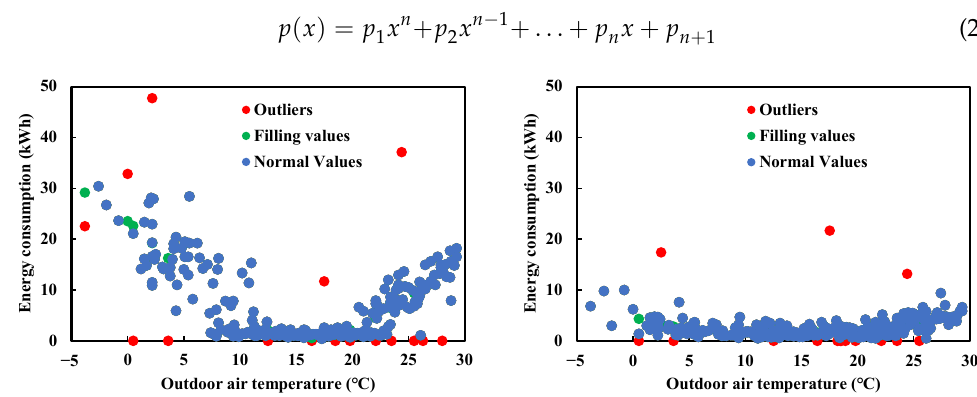
Figure 4. Results of data cleaning and filling in two typical rooms.